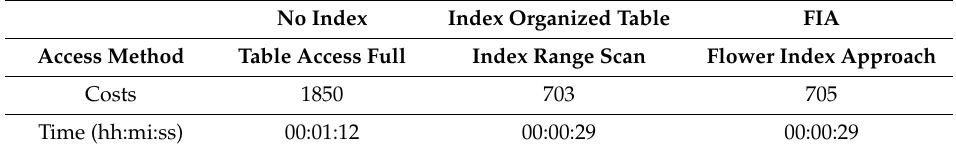
Table 2. Index processing—costs and time demand in one index